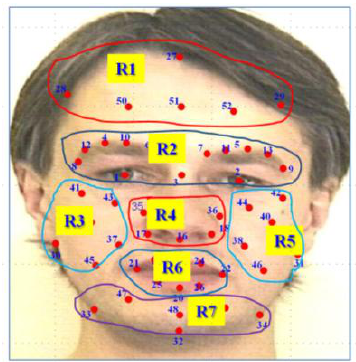
The selected features for each facial expression are either from the pair of landmarks within a region, or from the pair of landmarks from two regions. Table 1 lists the region, as well as the pair of regions, from which the landmarks are chosen to extract the most discriminative feature vector for each facial expression. A single or pair of landmarks within region R2, which is the eye and eyebrow region, is used to build the discriminative feature vectors for all the facial expressions. Pairs of landmarks from region R1–R2, and R2–R3 also have the discriminative information for almost all facial expressions. Region R6, the mouth region, contains discriminative landmarks for anger and sadness facial expressions. Table 1 shows more detail of the different regions of the face, from which the landmarks tracking results are used to build most of the discriminative feature